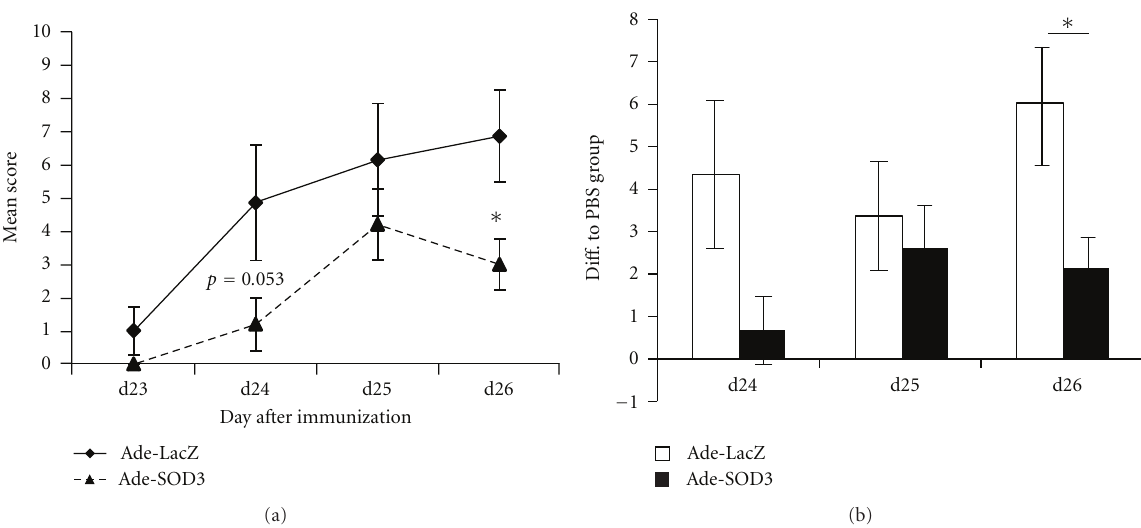
Figure 2: SOD3 downregulated arthritis in wild-type B10.Q mice. Adenovirally expressed SOD3 reduced arthritis severity in the treated paws (a) in wild-type B10.Q mice (Ade-SOD3 n = 6, Ade-lacZ n = 7). When compared to the PBS-treated injection control ( n = 8) group, Ade-SOD3-treated mice had less increase in the arthritis score in the treated paw than the Ade-LacZ-treated control mice (b).